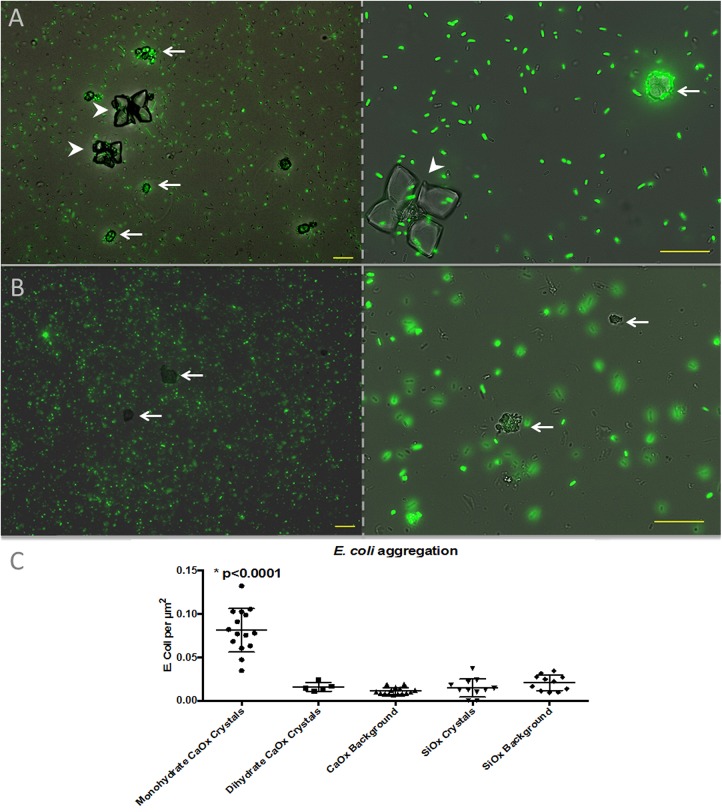
UPEC selectively aggregate around CaOx monohydrate crystals: following incubation with GFP labeled UPEC, bacteria (green) could be seen aggregating around CaOx monohydrate (A, arrows) but not CaOx dihydrate (A, arrowheads) or silicon dioxide (B, arrows) crystals.At 12 hours, significantly more bacteria per crystal surface area were seen with CaOx monohydrate crystals than with CaOx dihydrate crystals, silicon dioxide crystals or background. There were no other significant differences between groups. Magnification 40X right panels, 100X left panels Scale bars = 20 microns. Incubation time = 6 hours for left panels and 12 hours for right panels.